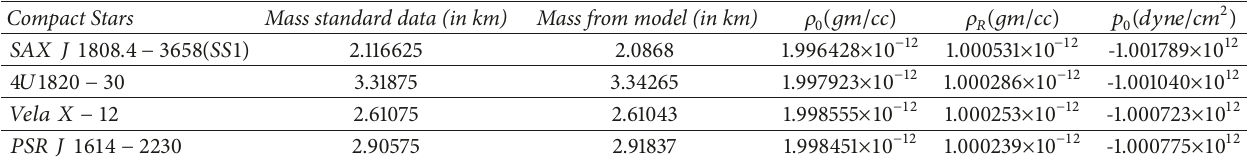
Table 2: Calculated values of mass, energy density, and pressure from our model.